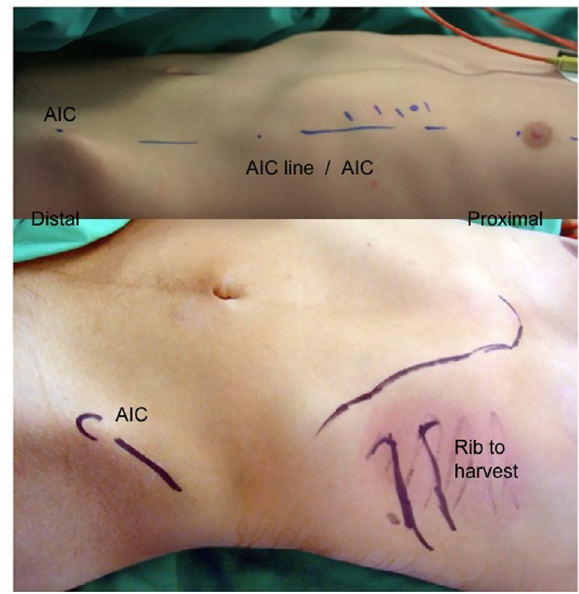
Figure 2. Landmarks of harvesting the graft: the junction between bone and cartilage is located approximately on the line joining mamelon and iliac crest (AIC).